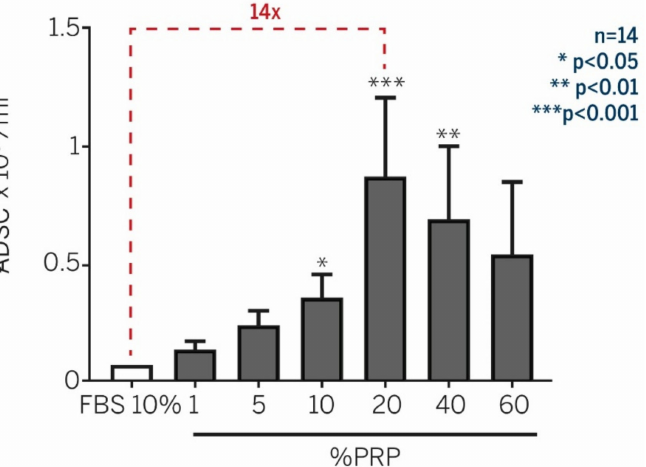
Figure 7. Culture media supplemented with autologous PRP drastically enhanced in vitro prolifer- ation, in comparison to the classical culture medium with 10% FBS. Data from Atashi et al. Tissue Engineering. Part C. 2014